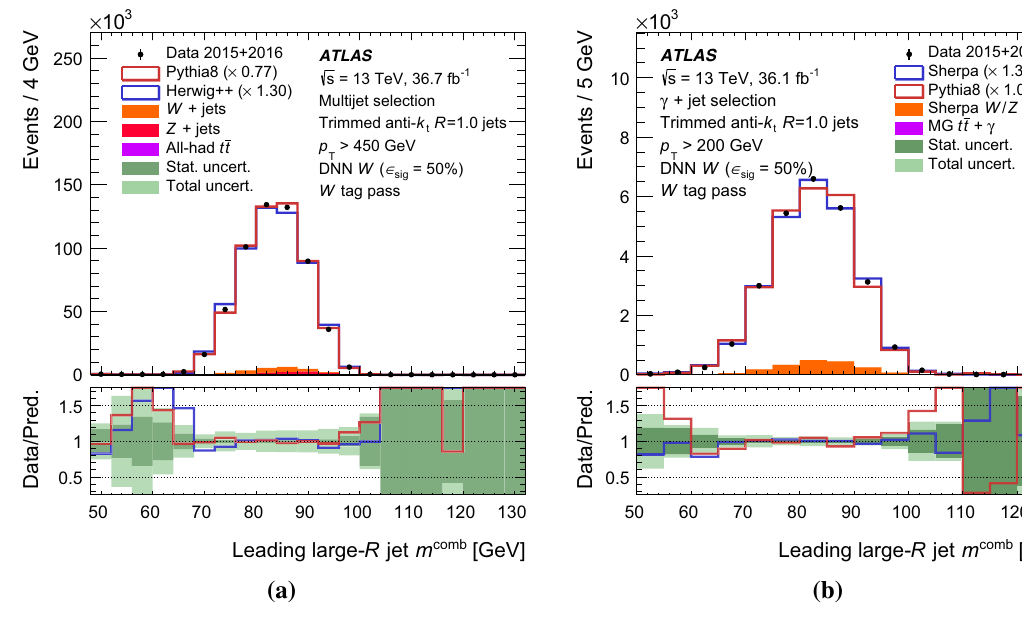
Fig. 31 A comparison of the observed data and predicted MC distri- butions of the anti- k t R = 1.0 trimmed jet m comb observable for events from the multijet ( a ) or γ + jet ( b ) selections that pass the selection on the jet-shape-based W -boson DNN tagger. The data-driven normalisa- tion correction, described in Sect. 6.2.1, is shown in the legend beside